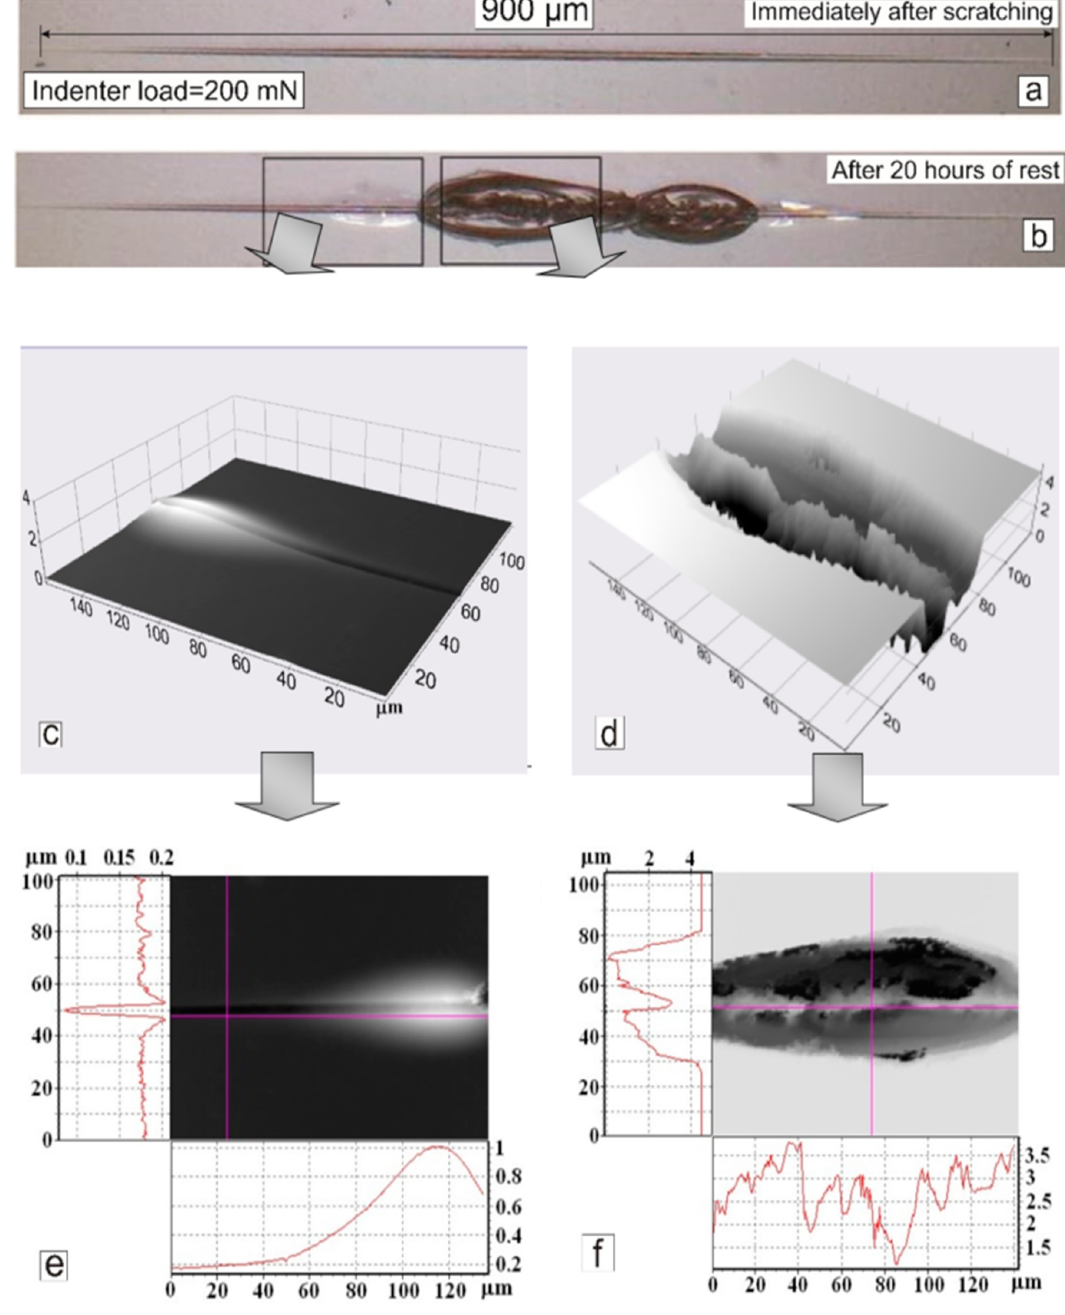
Figure 7. Scratch micro photos immediately after scratching ( a ) and after 20 hours of rest ( b ) as well as enlarged 3D images ( c ) and ( d ) and 2D images ( e ) and ( f ) of selected areas of the profile at a maximum load of 200 mN.